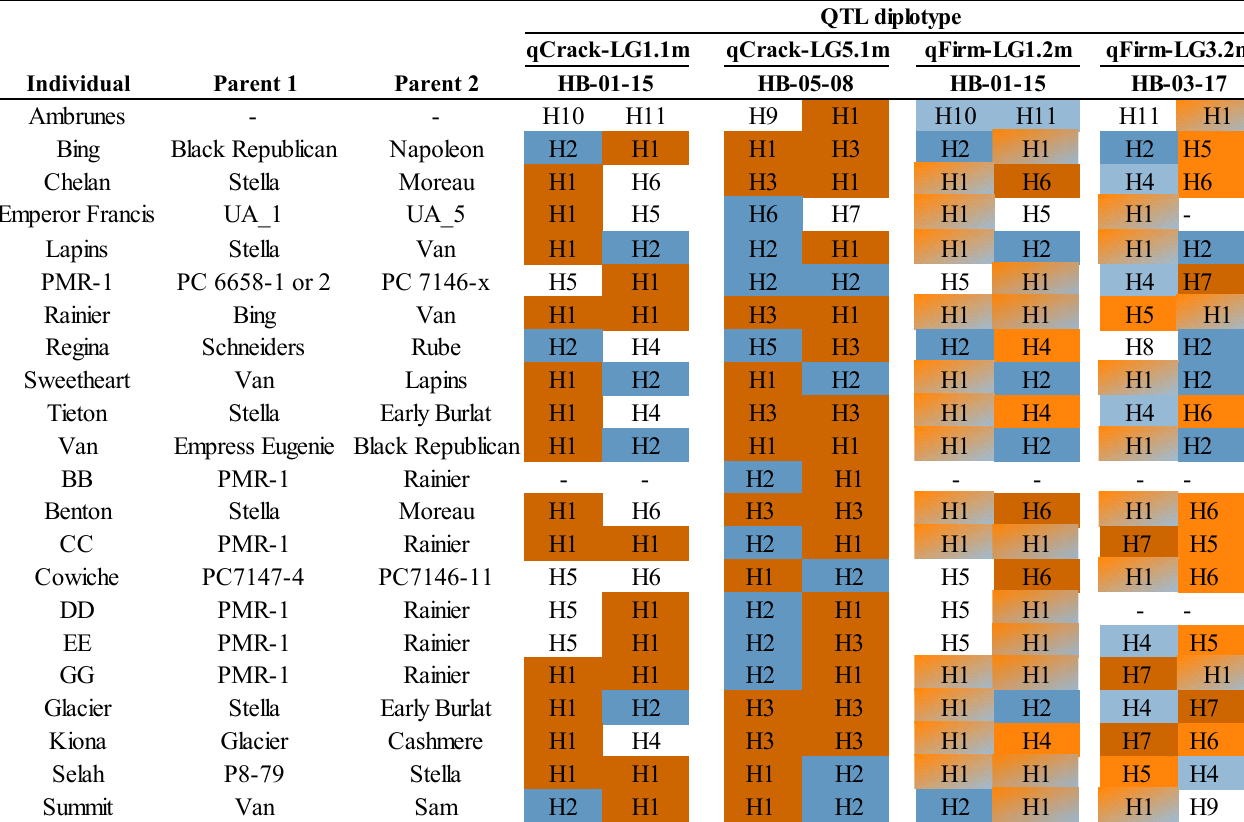
TABLE 2 | Diplotypes of 22 important breeding parents at each of four stable